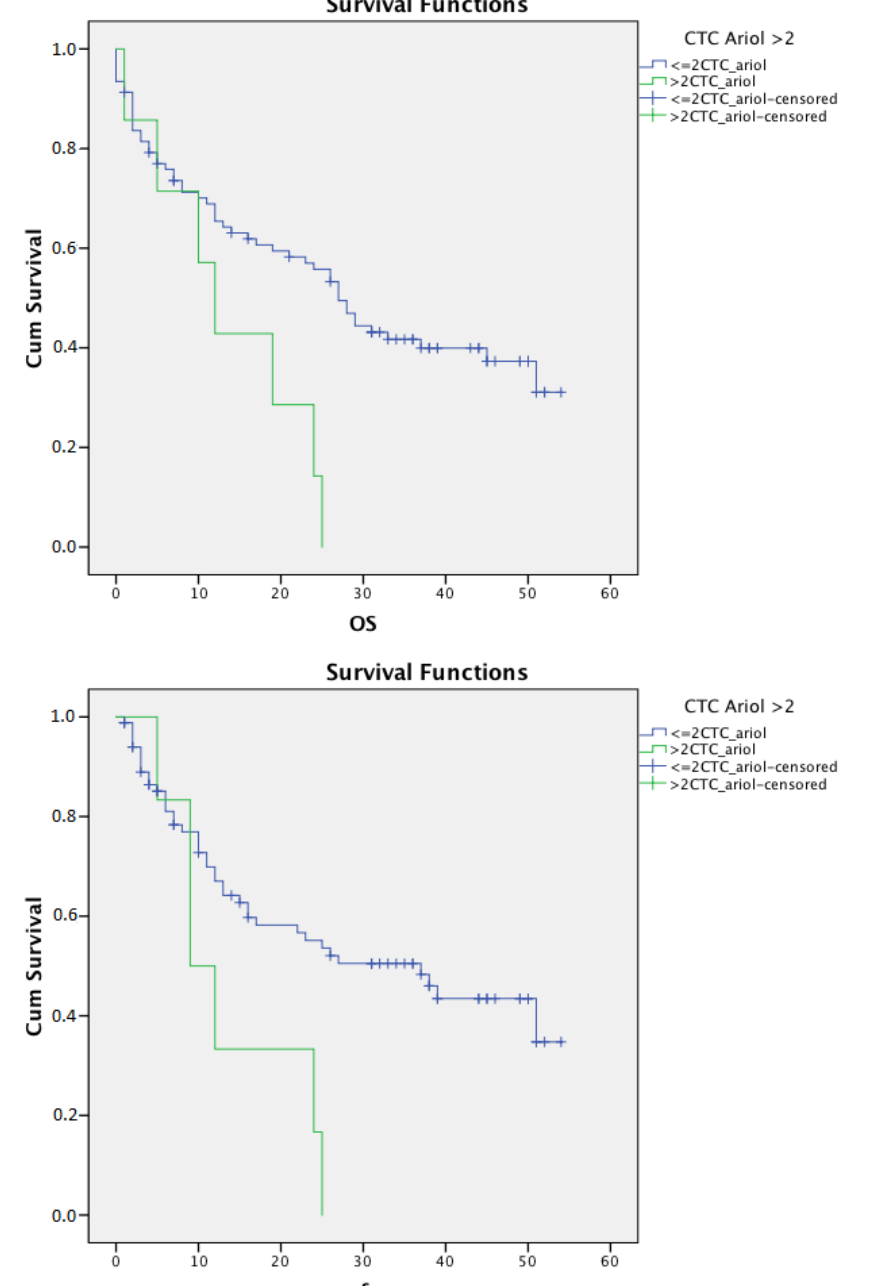
Figure 3. Kaplan-Meier curves for overall and progression-free survival according to > 2 circulating tumor cells (CTC) detection by Magnetic Cell Separation (MACS) enrichment / Ariol. Patients with > 2 CTCs detected by MACS enrichment / Ariol showed significantly shorter relapse-free ( p = 0.02) and overall survival ( p = 0.015) compared with CTC-negative